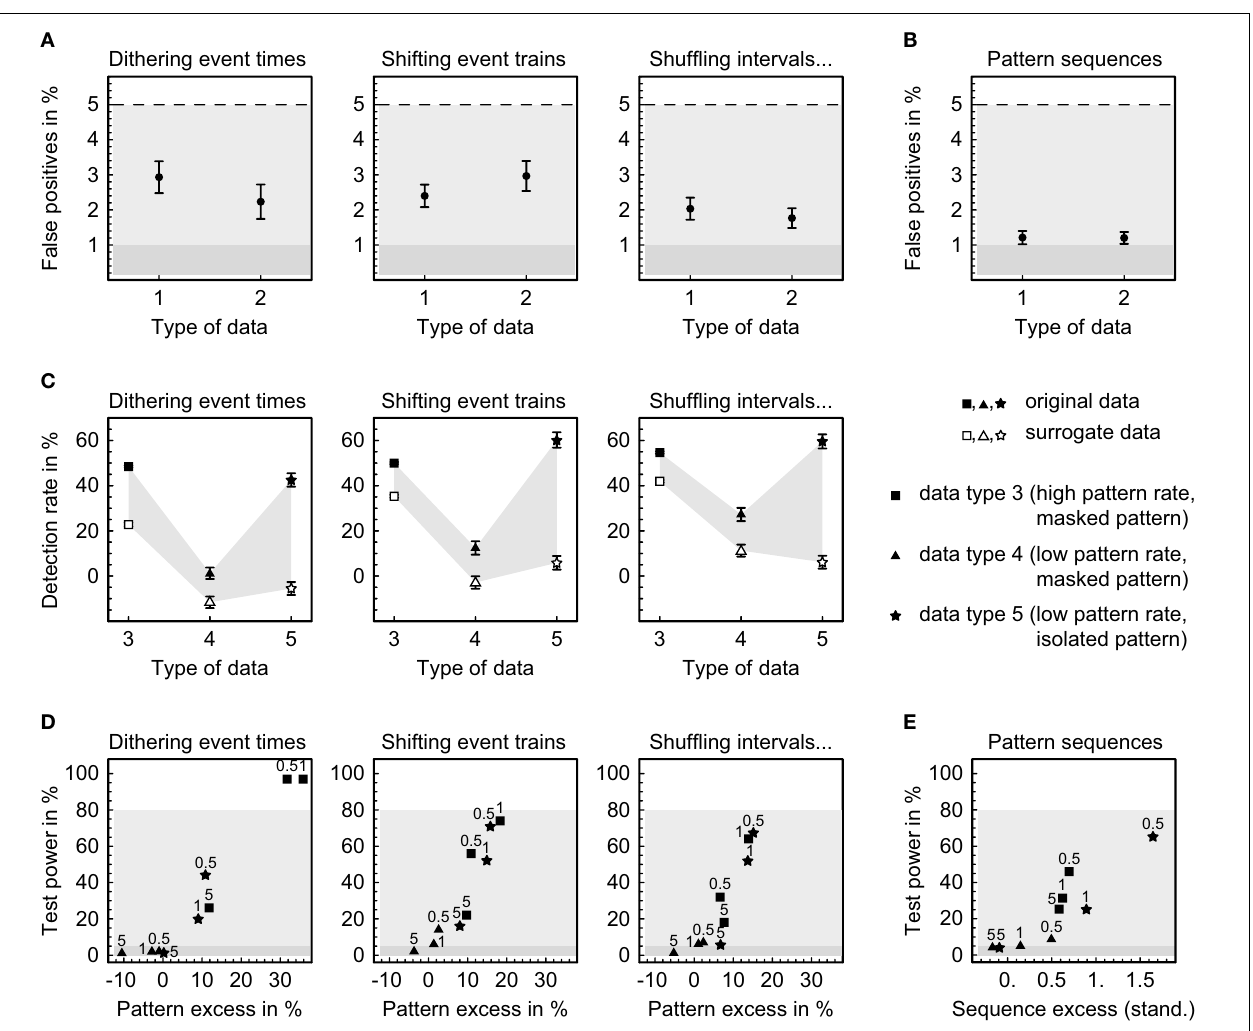
FIGURE 6 | Error levels in pattern detection and validation. Sets of 30 parallel simulated time series were generated by gamma processes featuring independent rate modulations (data type 1), rate covariations (data type 2) and precisely repeating spatiotemporal patterns and pattern sequences (data types 3, 4, and 5; see “DATA SIMULATION” in the appendix for further description). Error levels were estimated for each parameter combination based on 100 independently simulated data sets. (A) Rate of false positives (mean ± SEM) when analyzing spatiotemporal patterns using 30 different pattern definitions given by 10 different time windows W (5, 10, 15, 20, 25, 30, 35, 40, 45, and 50ms) and three different relative timing precisions (10 bins, 5 bins, and rank order). (B) Rate of false positives (mean ± SEM) when